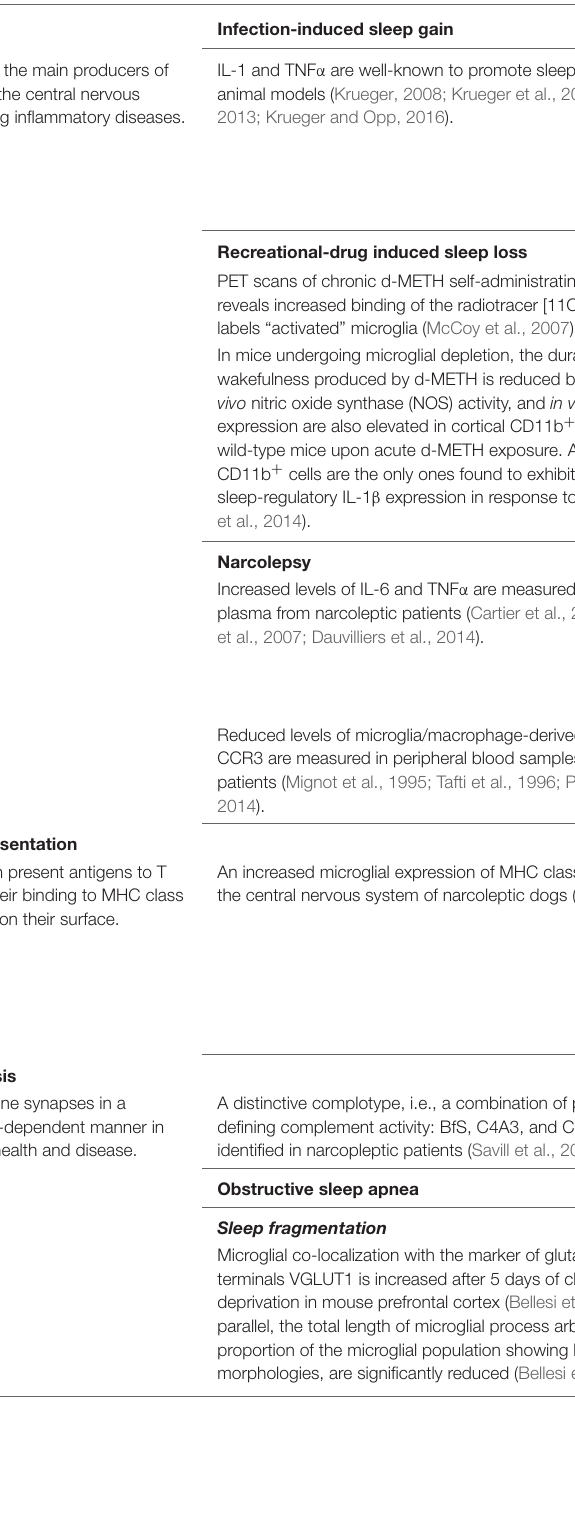
TABLE 1 | Microglial functions and relevance to sleep disorders. Neuroinflammation Experimental findings Suggested implication Infection-induced sleep gain Microglia are the main producers of cytokines in the central nervous system during inflammatory